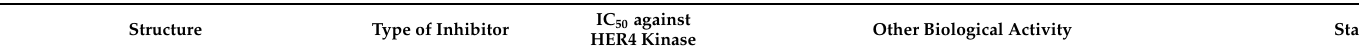
and MNK1 in vitro. In mice carrying subcutaneously implanted human tumor xenografts driven by HER family targets, including mutated EGFR, dacomitinib inhibited EGFR and HER-2 autophosphorylation and tumor development.